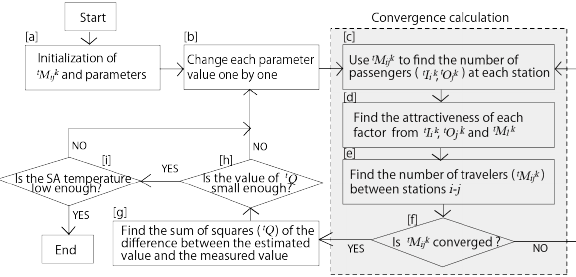
Figure 2 . Estimation method for the unknown parameters.